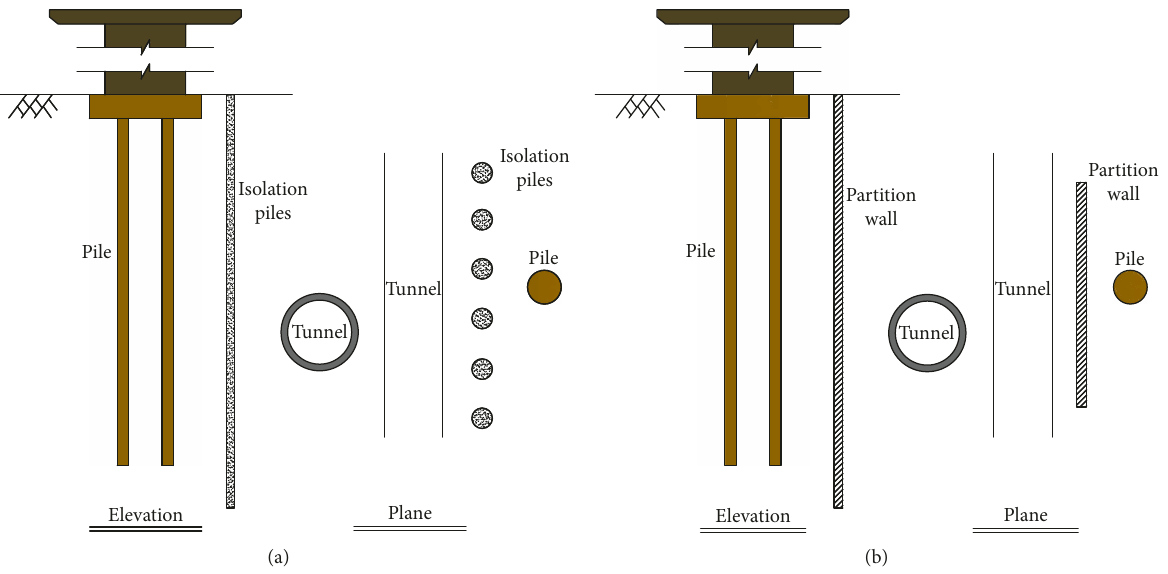
Figure 9: Isolation scheme: (a) isolation piles; (b) partition wall.